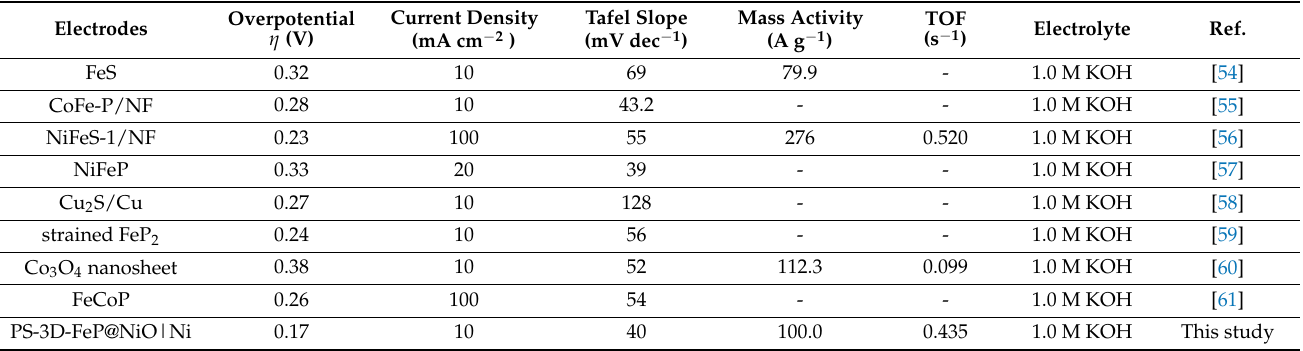
Table 1. Comparison of the OER performance of the developed PS ‐ 3D ‐ FeP@NiO|Ni electrode with the recently reported catalysts.